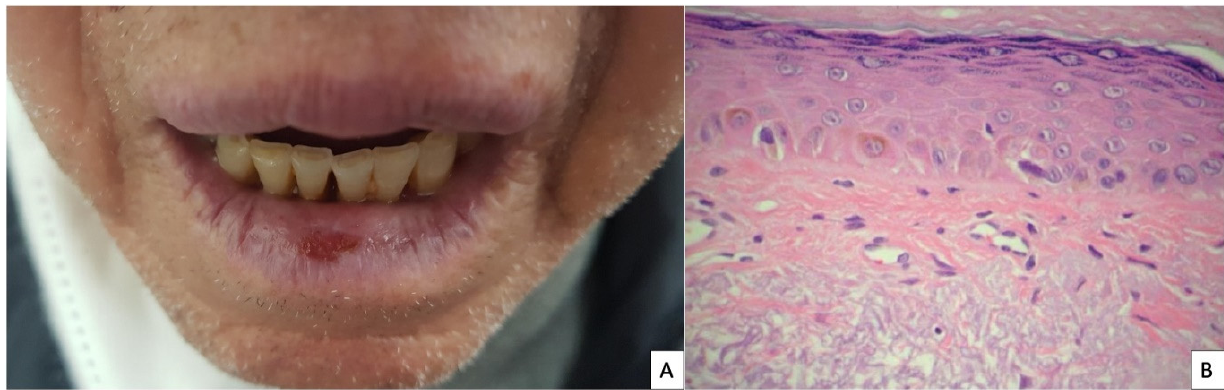
Figure 1. ( A ) Clinical image: poorly demarcated border of the lower lip with a erosion ( B ) Histopathological image, adapted with permission from Ref. [12] Copyright 2012 Vieira et al.: hyperkeratosis and atrophy of the epidermis, with discrete dysplasia, and elastosis of the dermal collagen (HE 200×).